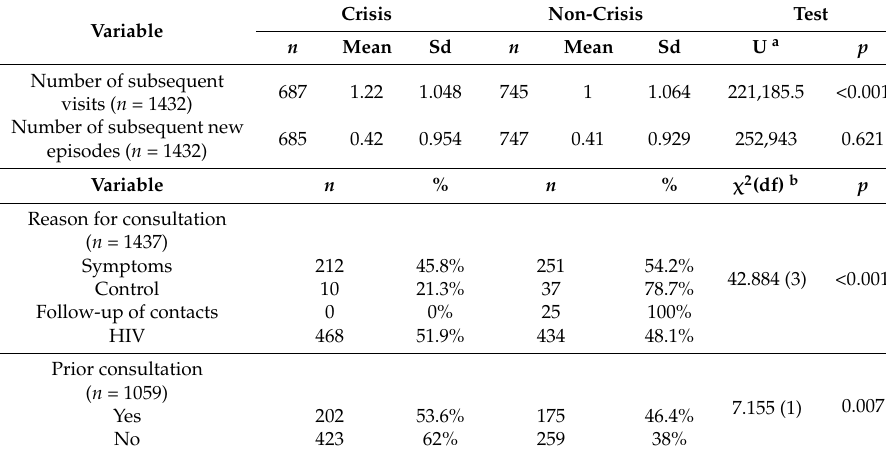
Table 2. Clinical Care during the Crisis vs. Non-Crisis